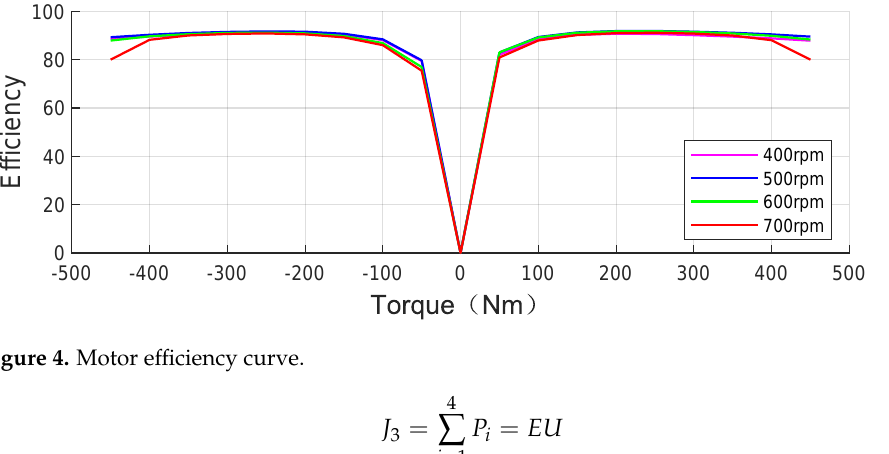
Figure 4. Motor efficiency